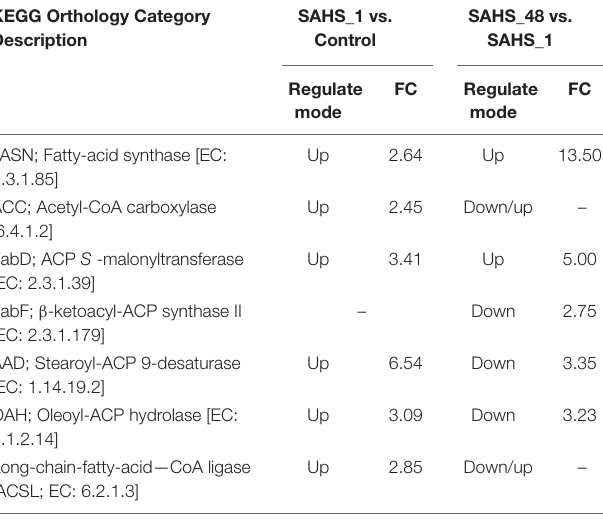
TABLE 7 | The up and downregulated genes related to the fatty acid biosynthesis pathway during SAHS Stage transitions. KEGG Orthology Category